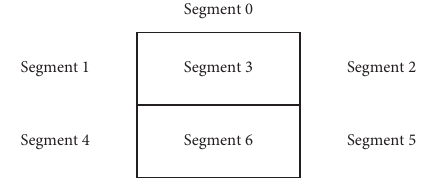
Figure 4: 7-segment digital structure.